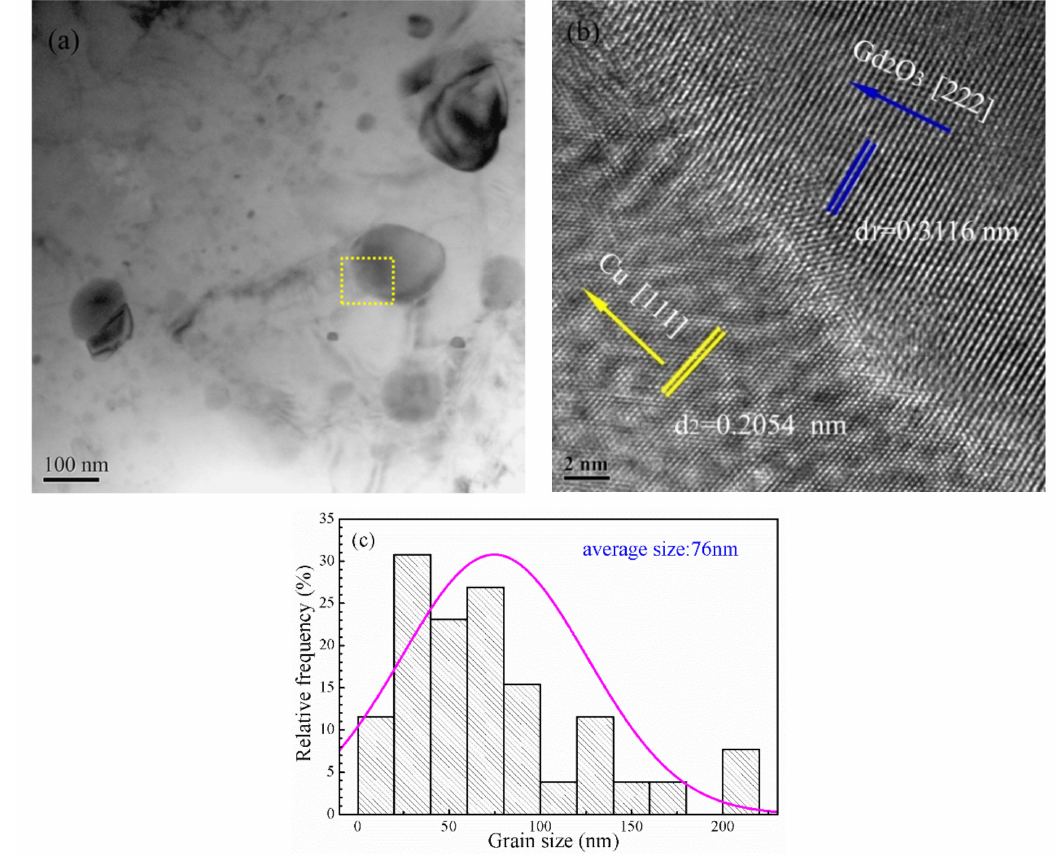
Figure 7. TEM images of the 1.5 vol% nano-Gd 2 O 3 /Cu composite: ( a ) bright field image, ( b ) high-resolution TEM image, and ( c ) average size of nano-Gd 2 O